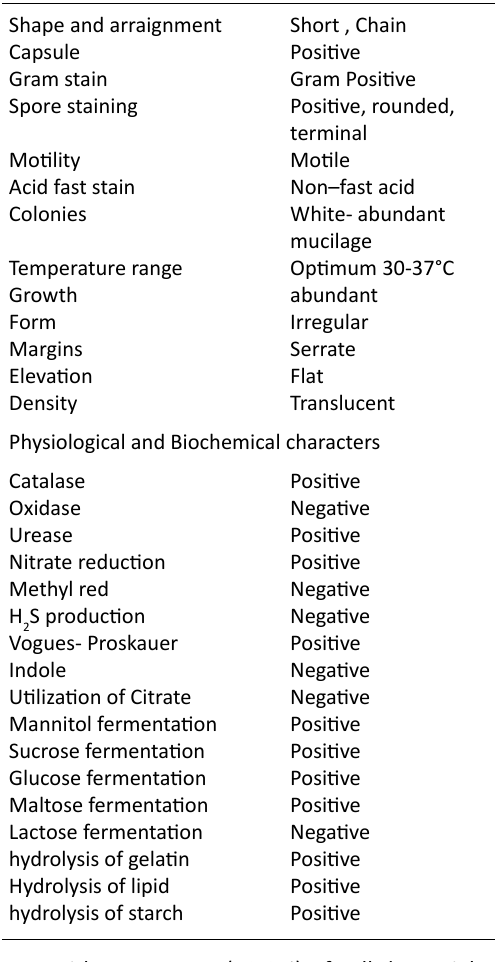
Table 5. Production of PHB by Bacillus during different